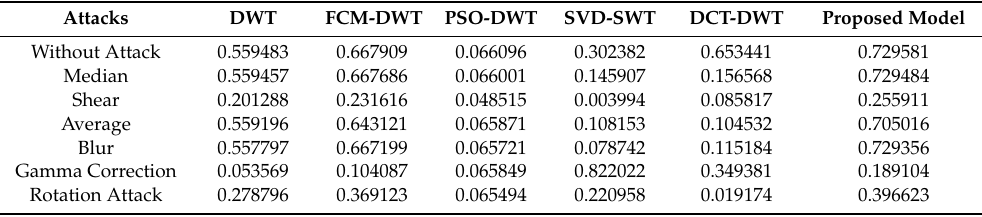
Table 4. Structural similarity index measures (SSIM) values of other models and the proposed model after